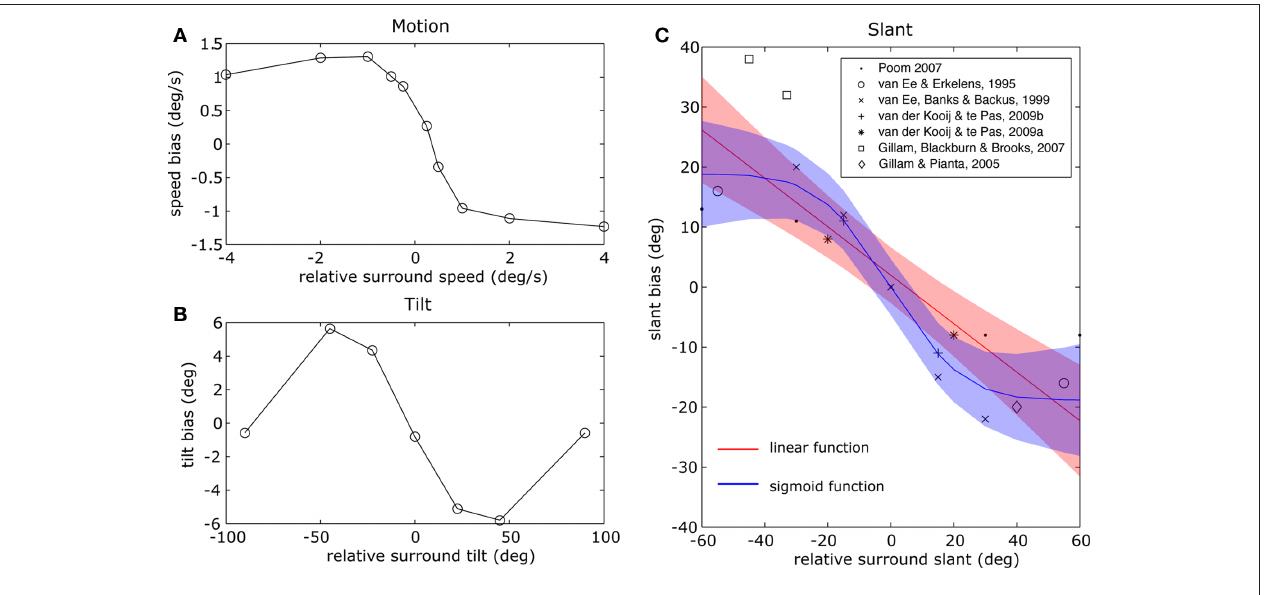
Figure 3 | (A) Biases in speed perception replotted from Baker and Graf (2010). (B) Biases in tilt perception replotted from Solomon et al., 2004. Note how the angle differences for which contrast biases disappear or change to assimilation have not been measured for slant perception. (C) Slant contrast biases,